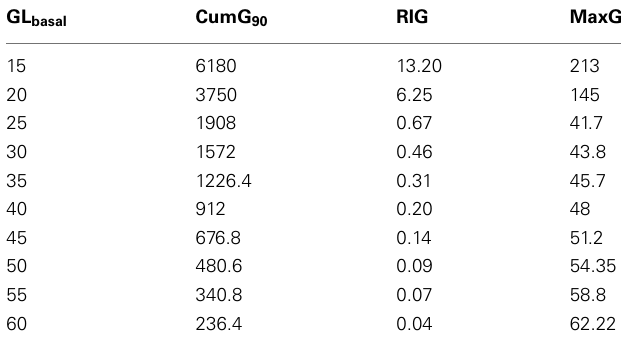
Table 3 | MaxG, CumG, and RIG at different levels of GL basal , which span the range detected in the experiments.